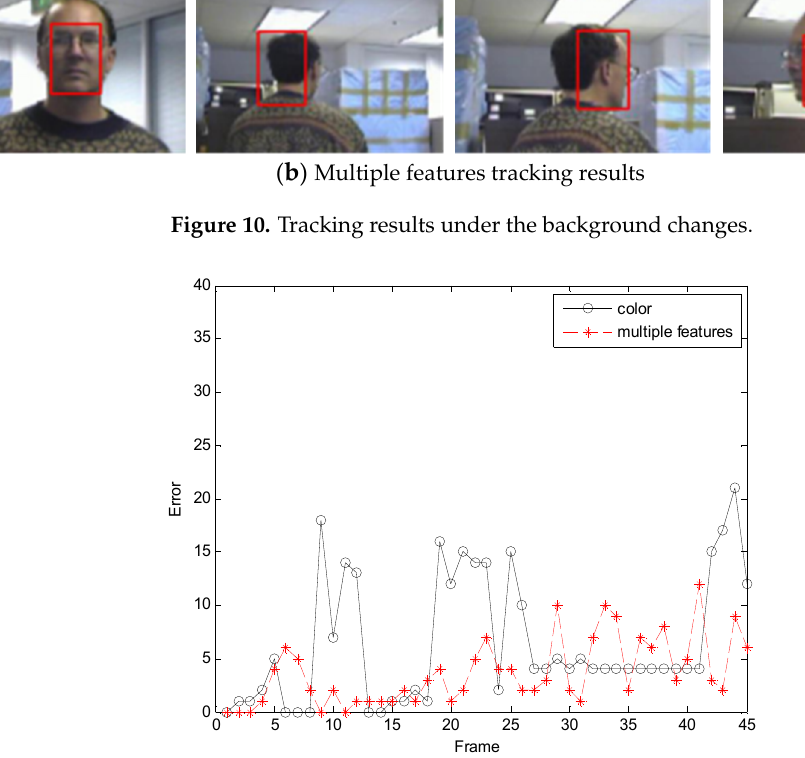
Figure 11. The RMSE comparison corresponding to background changes.